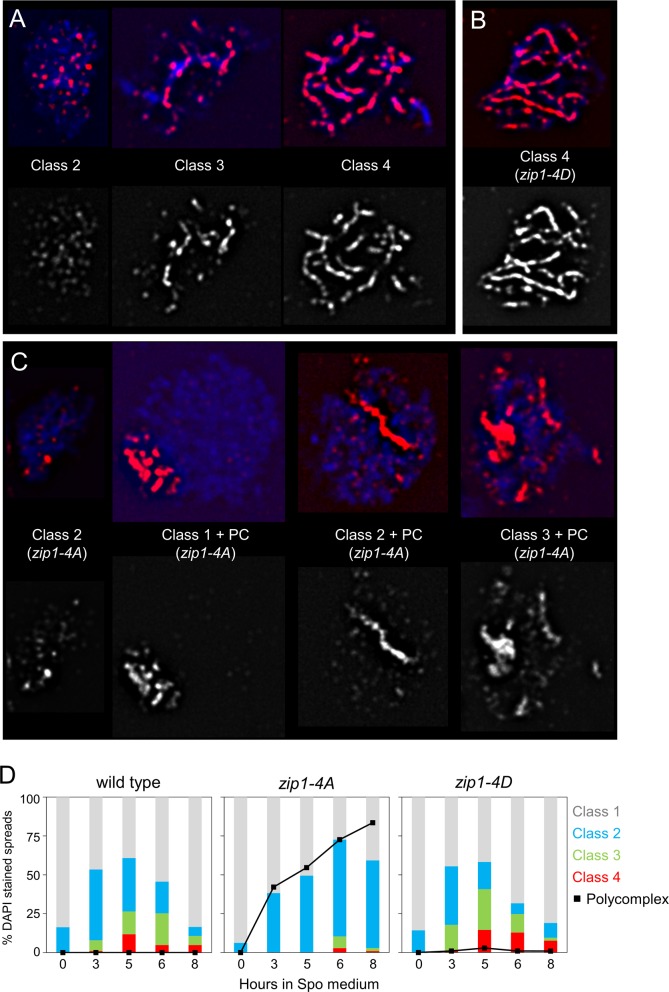
SC formation in various zip1 mutants.Homozygous WT (NH2297::p3822), zip1-4D (NH2297::p382-4D2), and zip1-4A (NH2297::p382-4A2) diploids were sporulated and cells taken at different time points and stained with DAPI to detect the chromatin and anti-Zip1 antibodies. Spreads were separated into four classes: 1) no Zip1 staining, (2) Zip1 foci only, (3) Zip1 foci and some lines and (4) fragmented/continuous smooth lines. (A) Spreads from the ZIP1 diploid showing the different classes of Zip1 staining. (B) A representative Class 4 nucleus from zip1-4D. (C) Examples of zip1-4A nuclei with PCs as indicated. Upper panels in A, B and C are images in which the DAPI and Zip1 signals were merged. The bottom panels show Zip1 staining alone. (D) Quantification of the different classes observed in meiotic time courses of the WT, zip1-4D and zip1-4A diploids. At least 100 nuclei were scored for each time point. The black line marks the total percentage of PCs at each time point.